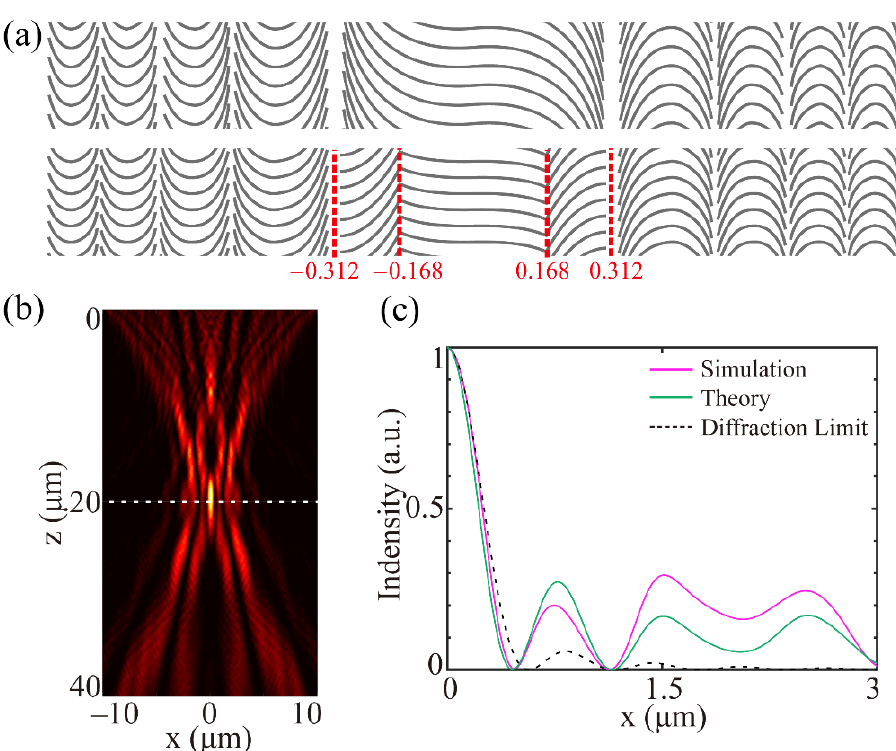
Figure 5. ( a ) Schematic of the QCMS (top row) and SOQCMS (bottom row), the red numbers indicate the normalized π -phase-jump radial positions. ( b ) Simulated field distribution along the propagating direction at the wavelength of 532 nm. ( c ) Normalized intensity curve along the white line in ( b ).